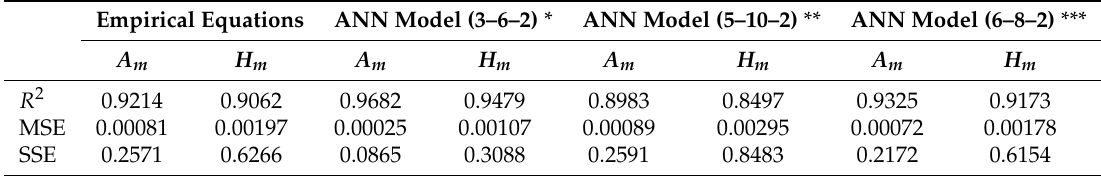
Table 4. The R 2 , MSE, and SSE values of the models